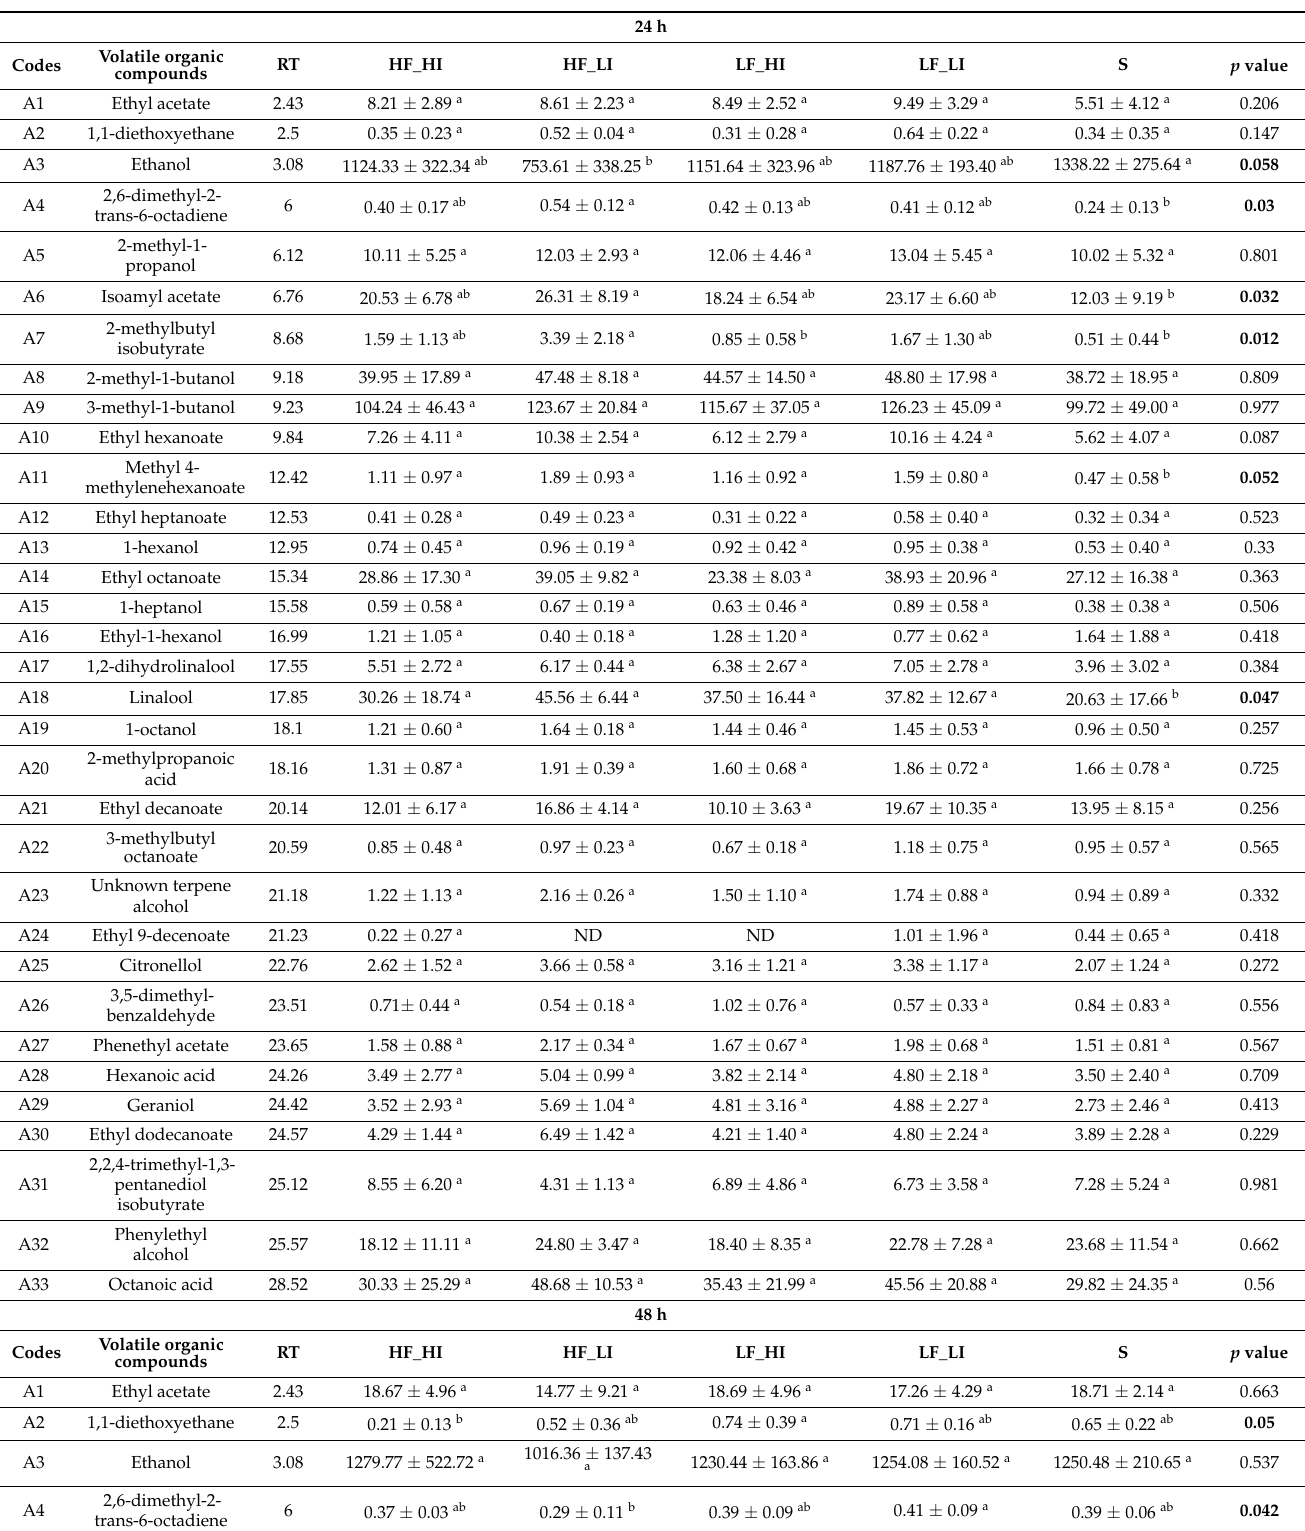
Table A1. Peak response areas ( × 10 4 TIC) of volatile organic compounds detected in beer fermentation under five sound treatments at 24, 48, 73, 96, 120, and 144 h sampling intervals during fermentation. 24